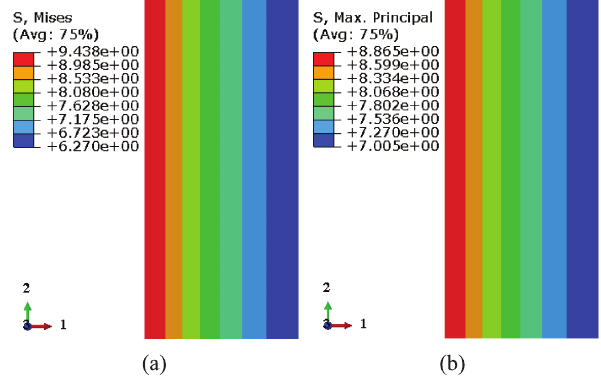
Fig. 4: The initial stress distribution of σ e and σ p at 1050 °C (t = 0):